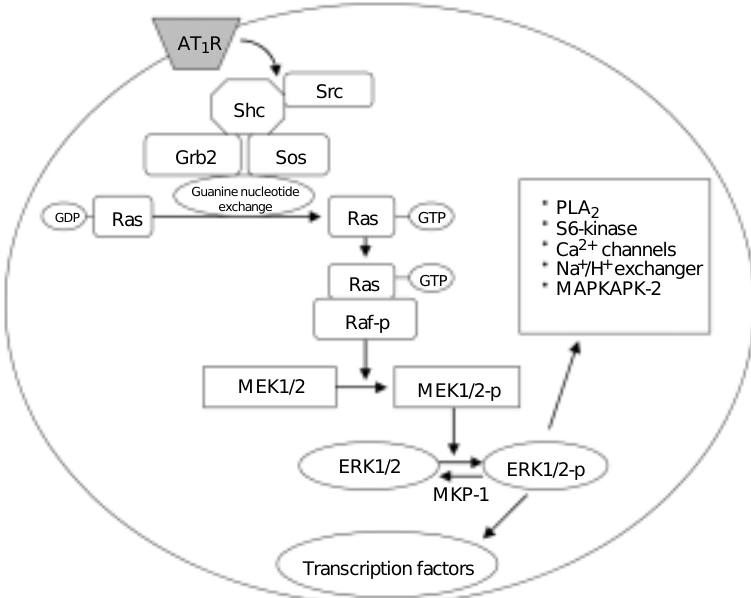
Figure 3. Ang II-stimulated extracellular signal-regulated kinase (ERK)-dependent signaling pathways in vascular smooth muscle cells. The ERK phosphorylation cascade is initiated by Ang II binding to angiotensin 1 receptors (AT 1 R) that induce Shc-Grb2-Sos formation (tyrosine phosphorylation of Shc) which in turn facilitates guanine nucleotide exchange on the small G protein Ras-GDP/GTP. Activated Ras-GTP interacts with the Ser/Thr kinase Raf (mitogen- activated protein kinase (MAPK) kinase kinase (MAPKKK)) which translocates to the cell membrane. Activation of Raf leads to phosphorylation of two serine residues present in MEK (MAPK/ERK kinase) which in turn phosphorylates Thr/Tyr and activates MAPK, present as a 44- (ERK-1) and a 42-kDa isoform (ERK-2). Phosphorylated ERK has diverse intracellular protein targets which it phosphorylates and activates. Dephosphorylation of ERK is accom- plished by activation of MAPK phosphatase-1 (MKP-1). PLA 2 - phospholipase A 2